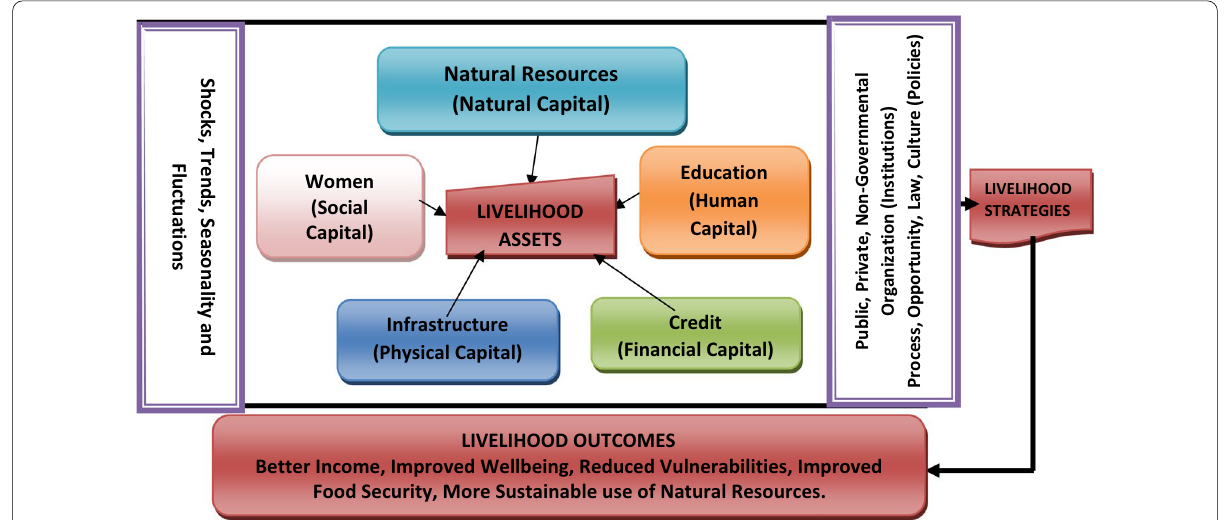
Fig. 4 Sustainable Livelihood Framework Source Adapted from the Department For International Development (DFID 2010)